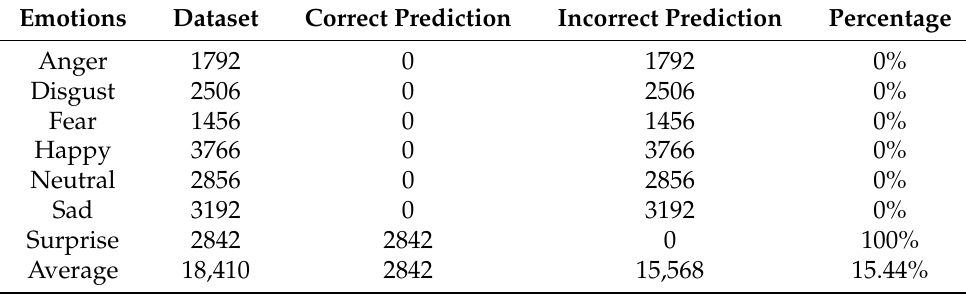
Table 13. Test result with prediction detail of Model 2 after 100